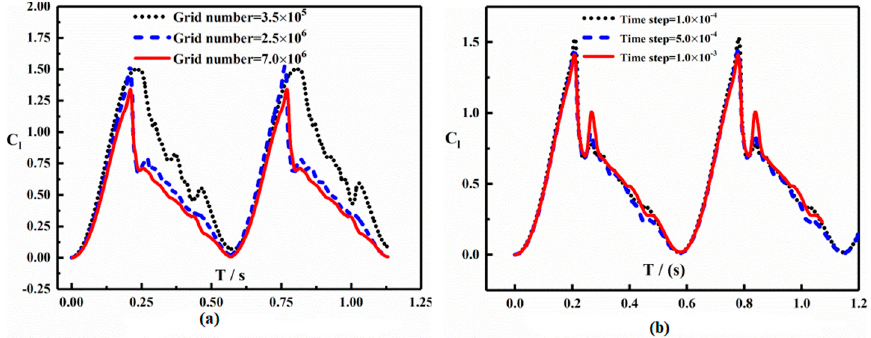
Figure 4. Computational domain and grids. ( a ) grid independence verification; ( b ) time step independence verification.